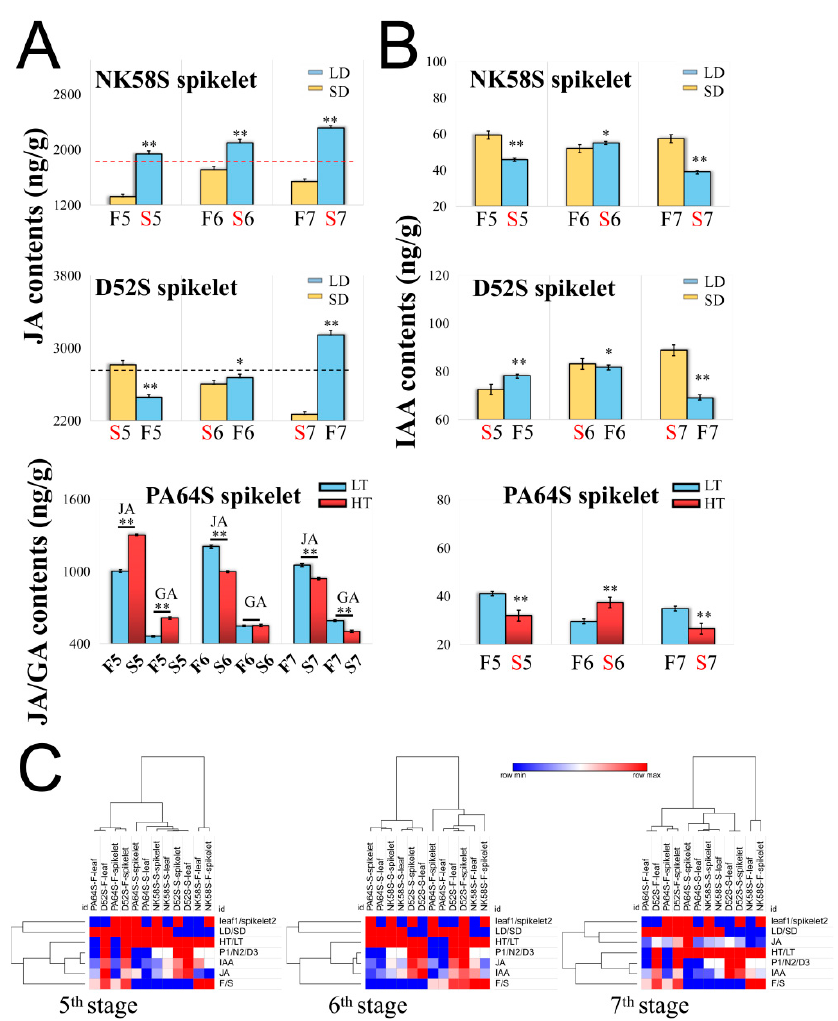
Figure 1. Analysis of hormone contents in D52S, NK58S and PA64S by photoperiod and temperature treatment. ( A ) JA and GA contents of spikelets from D52S, NK58S and PA64S treated by LD/SD and HT/LT. ( B ) IAA contents of spikelets from D52S, NK58S and PA64S. ( C ) Heatmap analysis of their hormone contents from 5th to 7th stages. The contents from HT/LT and LD/SD treated plants are columnar with red/blue and blue/yellow color, respectively. Data are shown as mean ± standard deviation ( n = 3). Asterisks indicate significant differences between sterile and fertile plants revealed by Student’s t -test (*, p < 0.05; **, p < 0.01) for each line at the same stages. LD, long-day cycle; SD, short-day cycle; HT, high temperature; LT, low temperature; S/F, sterile/fertile plants; 5/6/7, 5th/6th/7th-stage; JA, jasmonic acid; IAA, indole-3-acetic acid; GA, gibberellin.